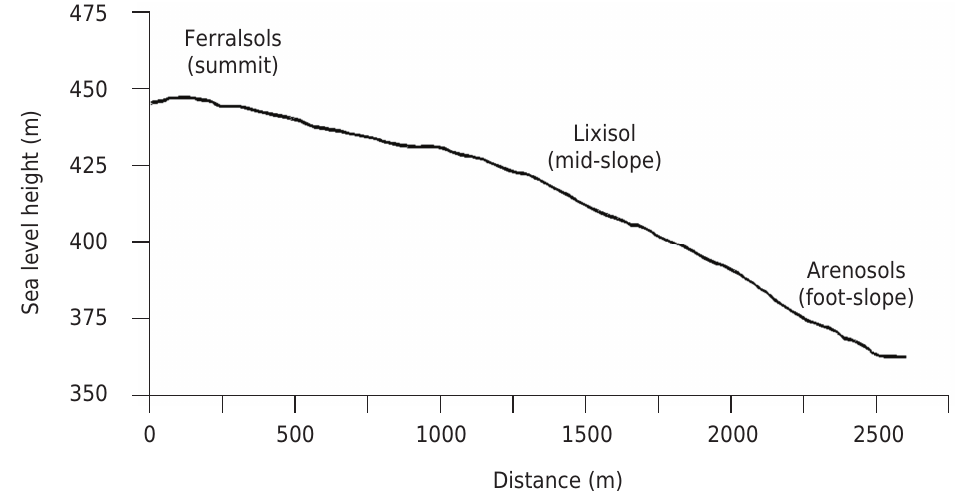
Figure 1. A schematic of the catena displaying different soils in the Caiuá Sandstone